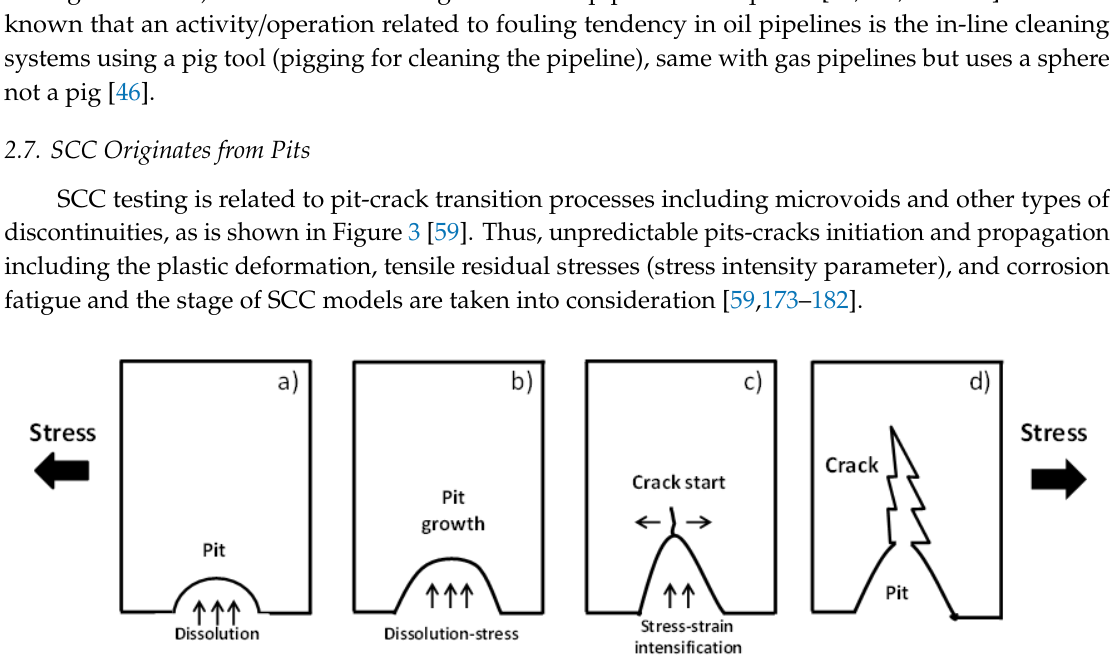
Table 1. Main external environments affecting operating pipelines to develop SCC.